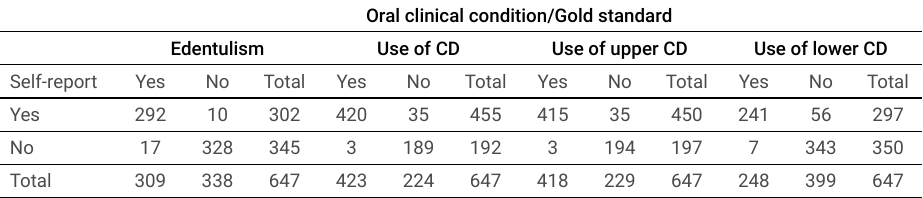
Supplementary table. Oral health condition self-reported according to the oral clinical